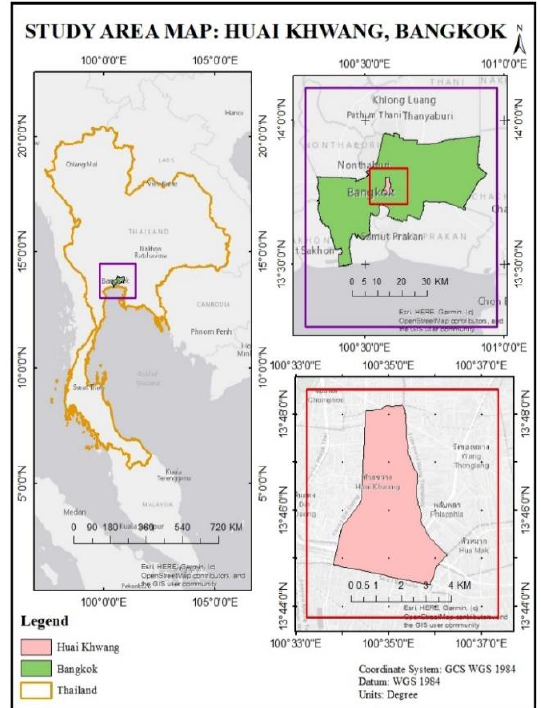
Figure 1. Study Area: Kings Fruits International Banana Farm